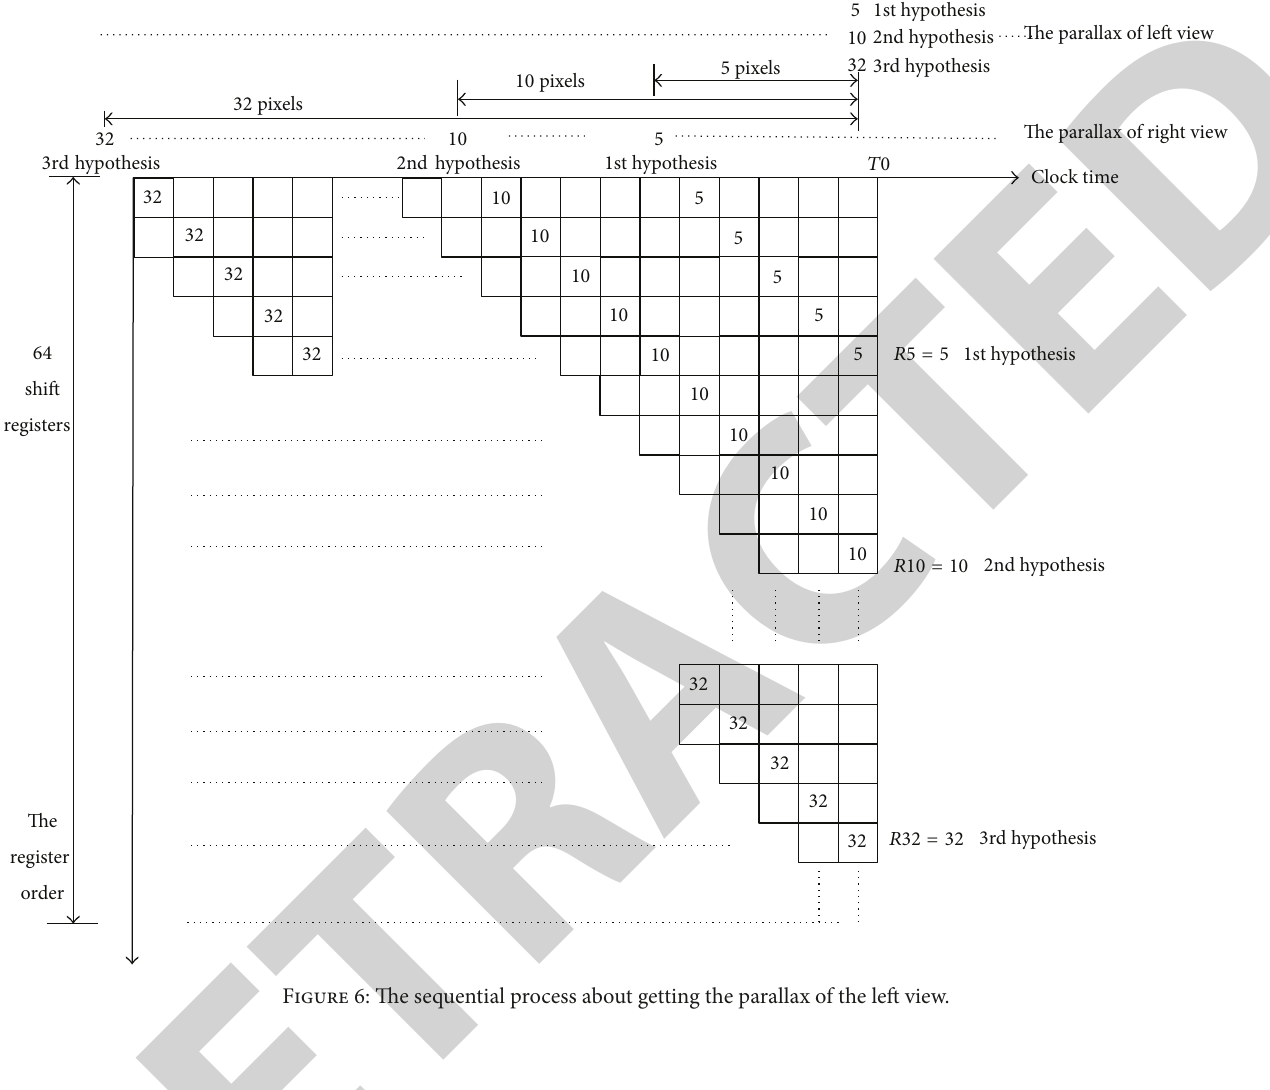
Figure 6: The sequential process about getting the parallax of the left